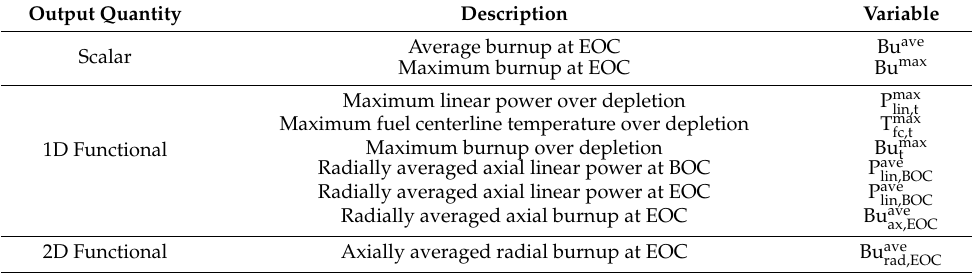
Table 7. Output quantities for depletion